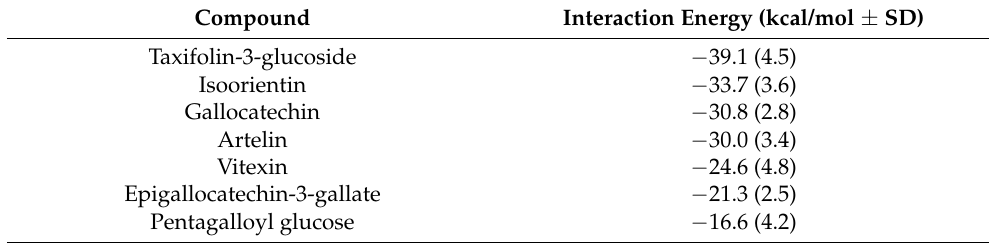
Table 2. Results of MM-GBSA analysis of the bovine Lf- PEL compounds complexes. For each compound, we reported the average interaction energy calculated over the last 30 ns of the